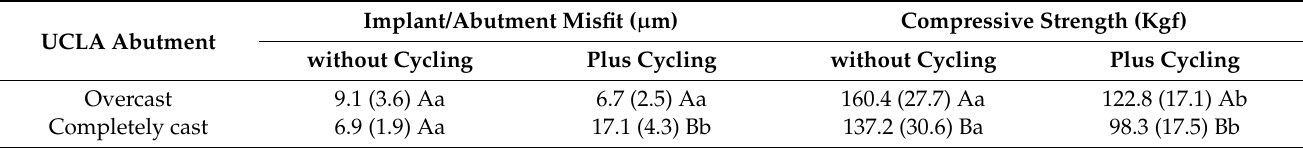
Table 2. Means and standard deviation of implant/abutment misfit and compressive strength of prosthetic screws, according to the type of abutment and presence of mechanical